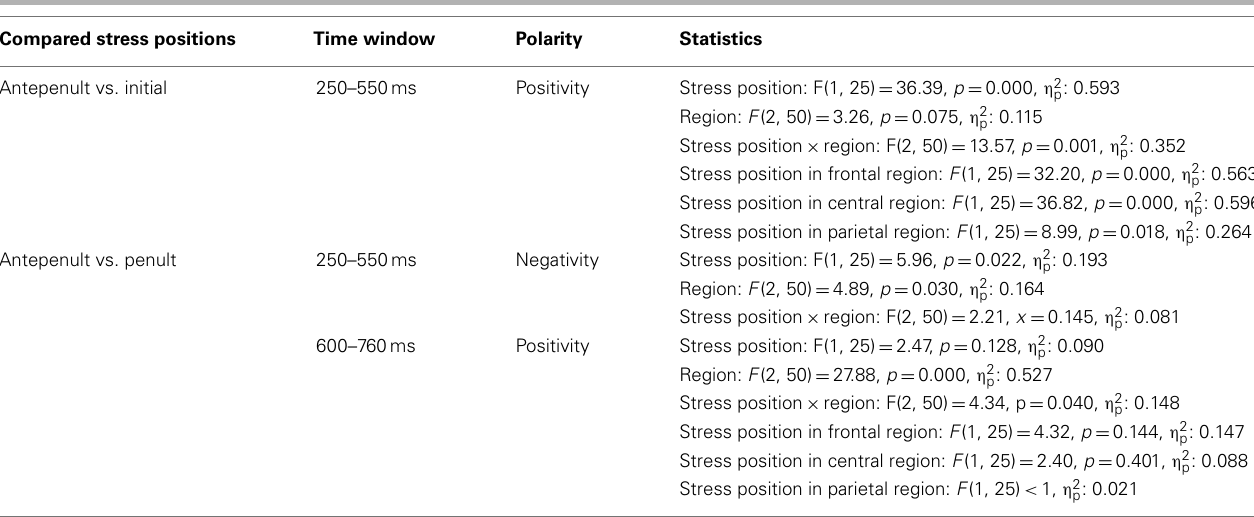
Table 6 |Words with canonical antepenultimate stress: results of statistical analyses of mean voltage changes for the factor stress position (correct antepenult vs. incorrect initial and penult) calculated over regions (frontal: F3, Fz, F4; central: C3, Cz, C4; parietal: P3, Pz, P4). COMPARISON BETWEEN CANONICALANTEPENULTIMATE STRESSAND OTHER STRESS POSITIONS Compared stress